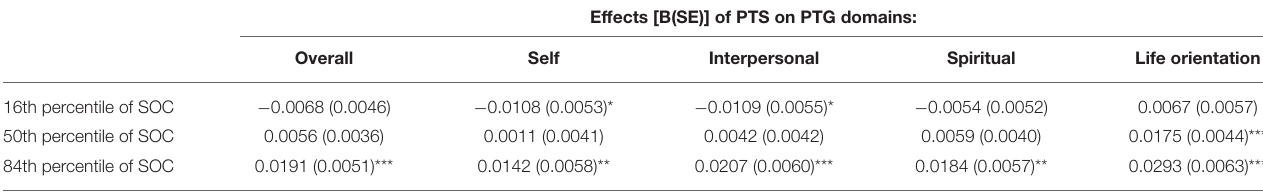
TABLE 4 | Effects of post-traumatic stress on post-traumatic growth at 16th, 50th, and 84th percentile of sense of coherence ( N = 327). Effects [B(SE)] of PTS on PTG domains: